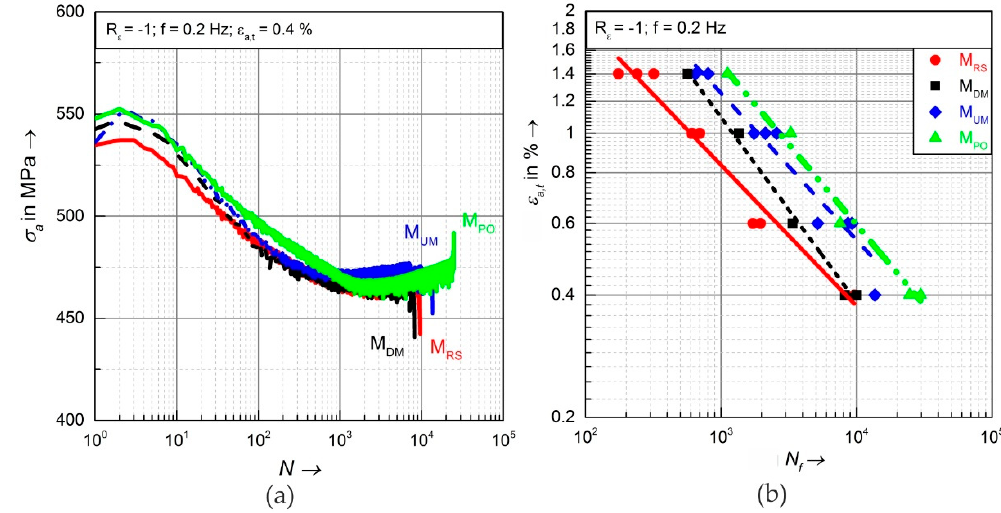
Figure 7. Low cycle fatigue behavior of HSD ® 600 TWIP steel with different surface morphologies: ( a ) development of stress amplitude ( σ a ) vs. number of cycles ( N ); ( b ) total strain S-N curve.